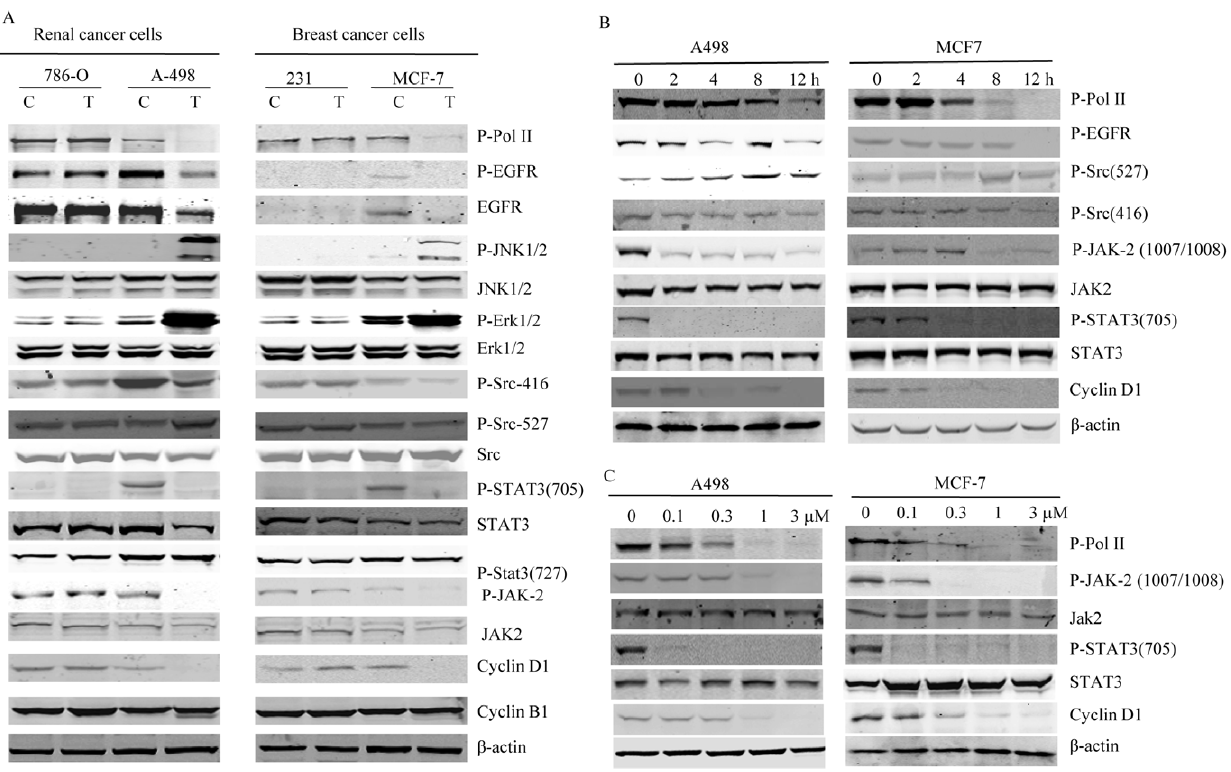
Figure 4. Modulating functions of multiple pathways by NSC-743380. A) Changes in molecular markers of various pathways after treatment with 1 m M NSC-743380 for 12 h in breast and renal cancer cells. C: controls; T: cells treated with NSC-743380. B) Time-dependent changes in p-EGFR, p-Src, p-JAK2, and p-STAT3 in A498 and MCF-7 cells after treatment with 1 m M NSC-743380. C) Dose-dependent changes in p-EGFR, p-Src, p-JAK2, and p-STAT3 in A498 and MCF-7 cells after treatment with different doses of NSC-743380 for 12